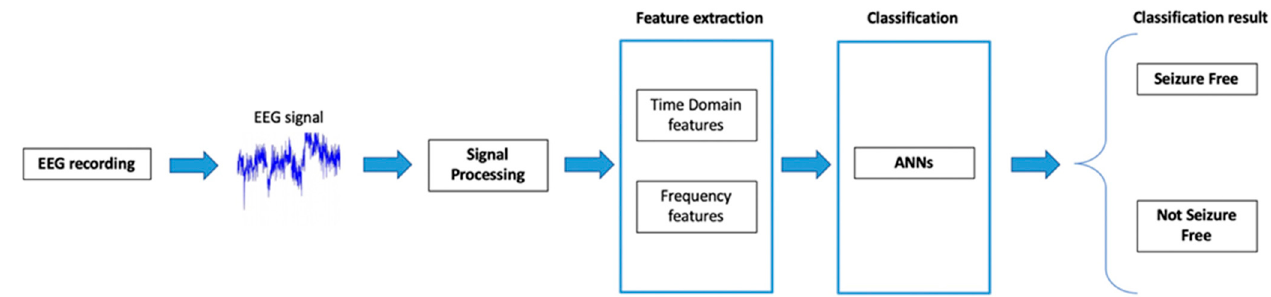
Figure 1. Diagram of the proposed surgery outcome prediction method of our study.